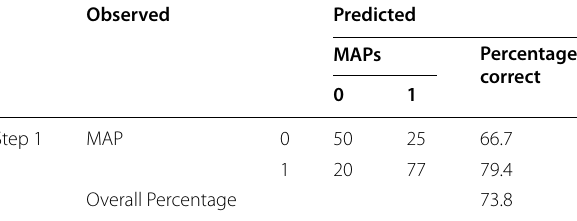
Table 5 Overall model classification